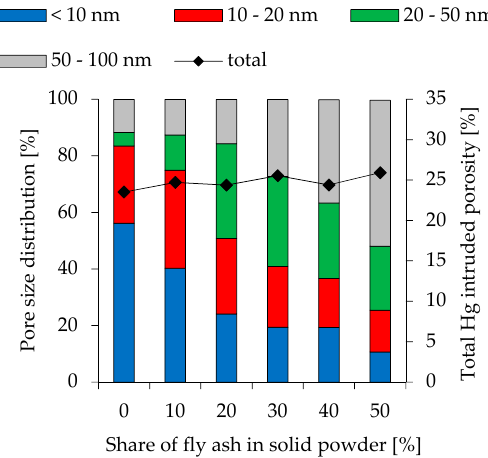
Figure 8. Pore size distribution of geopolymers cured for 28 days (l/s 0.49).